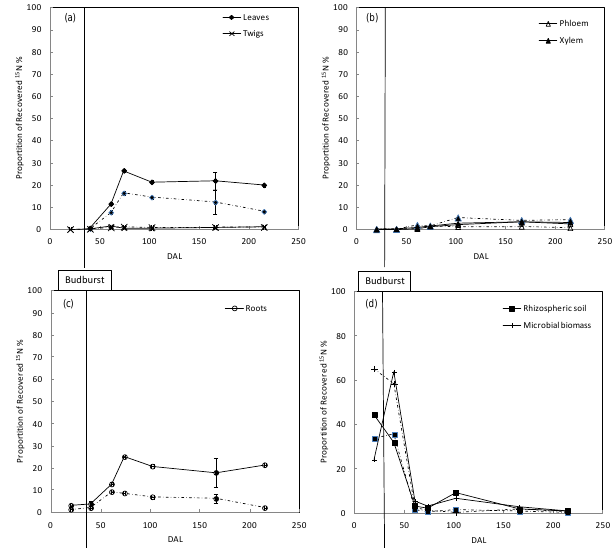
Figure 2. Partitioning of recovered 15 N (PRN%) from the sampled compartments following the second labelling campaign, i.e. from 9 September 2009 to 20 October 2010. (a) Leaves ♦ and twigs × , (b) phloem (cid:49) , (c) fine roots ○ , (d) rhizospheric soil ■ and micro- bial biomass + . DAL: days after labelling. The two lines for each category (continuous and dotted) correspond to tree 3 and tree 4. Vertical bars indicate standard errors.